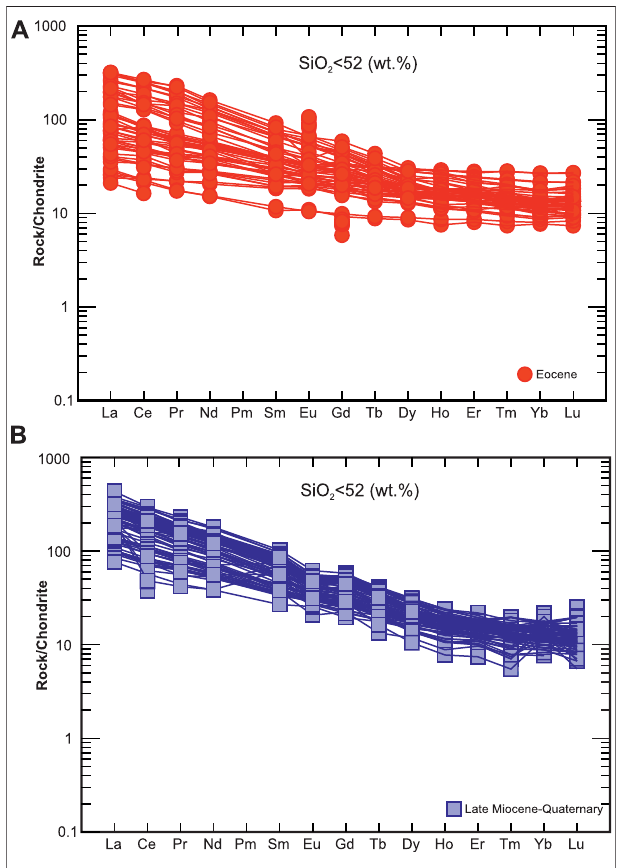
FIGURE 7 | Normalized REE abundances of the Eocene (A) and upper Miocene-Quaternary basic rocks (SiO 2 < 52 wt%) with chondrite values (Sun and McDonough, 1989). The normalized pattern shows that both the Eocene and upper Miocene-Quaternary rocks have higher ratios of light REEs than heavy REEs and negative slopes from LREEs to HREEs.